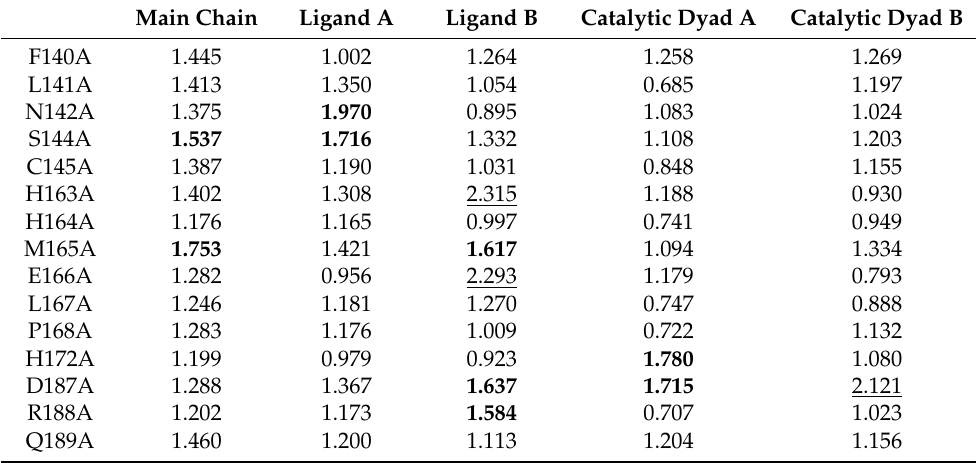
Table 2. Averaged RMSDs/Å for the last 10 ns MD trajectories of artificial mutants. Main Chain Ligand A Ligand B Catalytic Dyad A Catalytic Dyad B